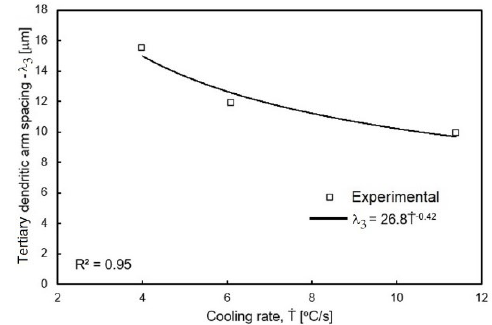
Figure 11. Tertiary dendritic arm spacing (λ